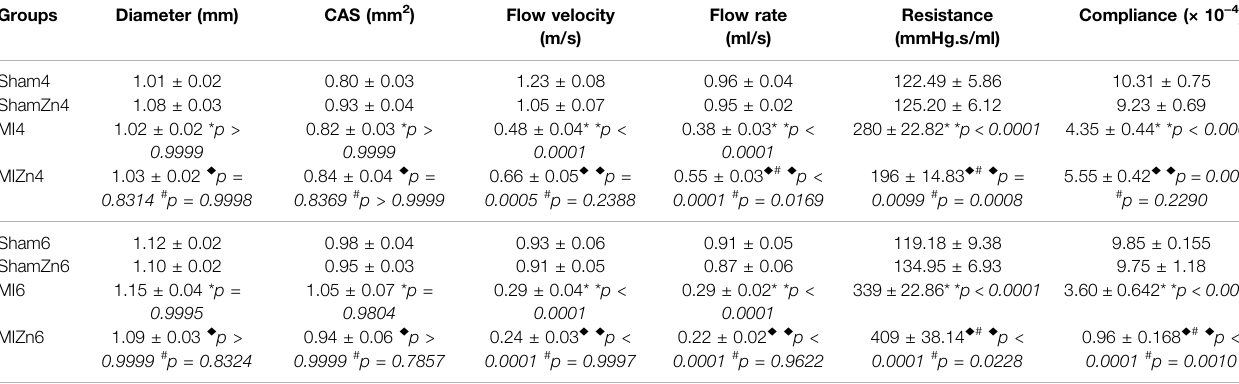
TABLE 2 | Morphological and hemodynamic parameters in the right carotid artery of eight groups.